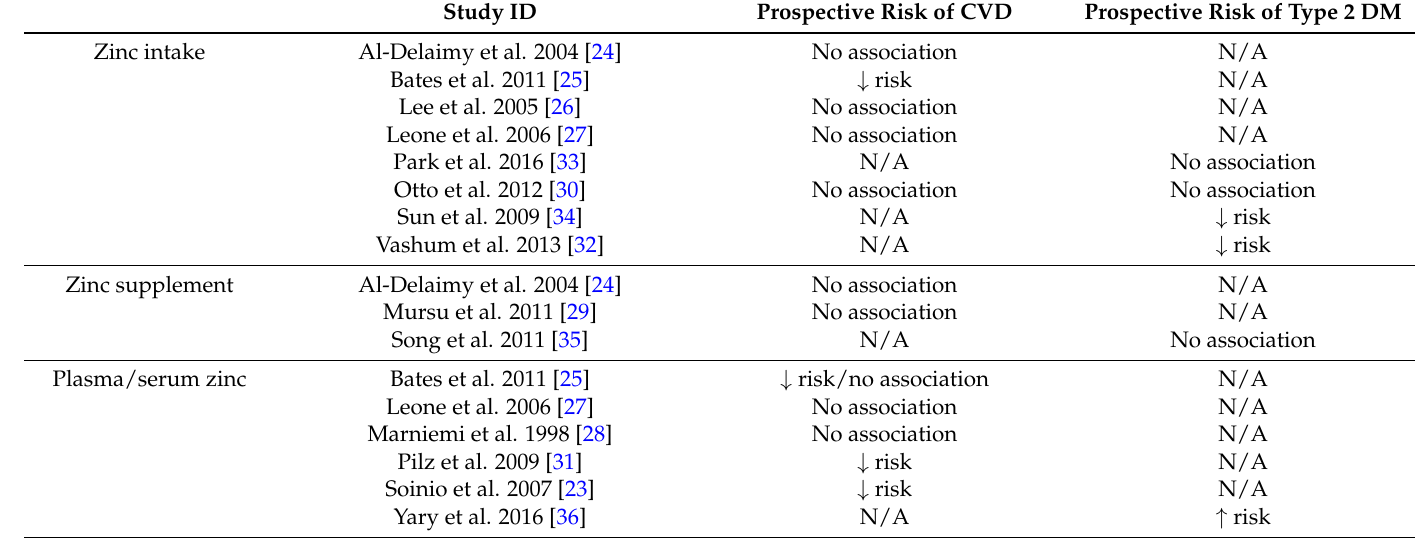
Table 4. Summary of relationships between increasing zinc status and prospective risks of cardiovascular diseases and Type 2 diabetes